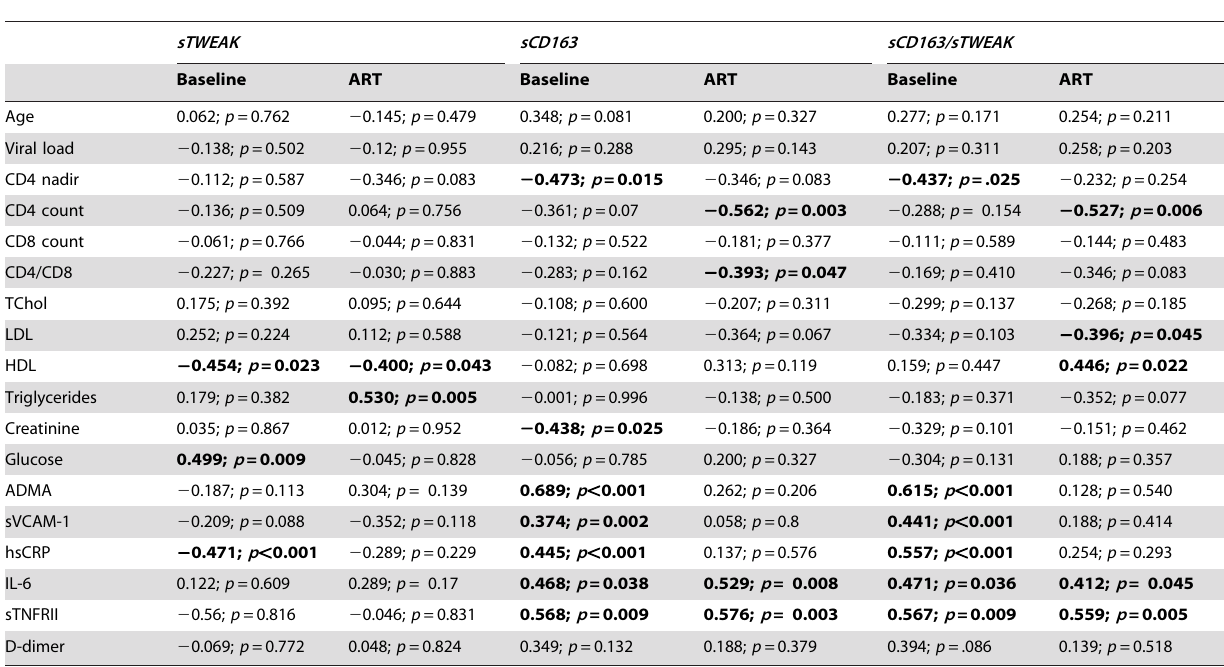
Table 2. Correlation between sTWEAK, sCD163 and sCD163/sTWEAK with immunovirological, inflammatory and endothelial